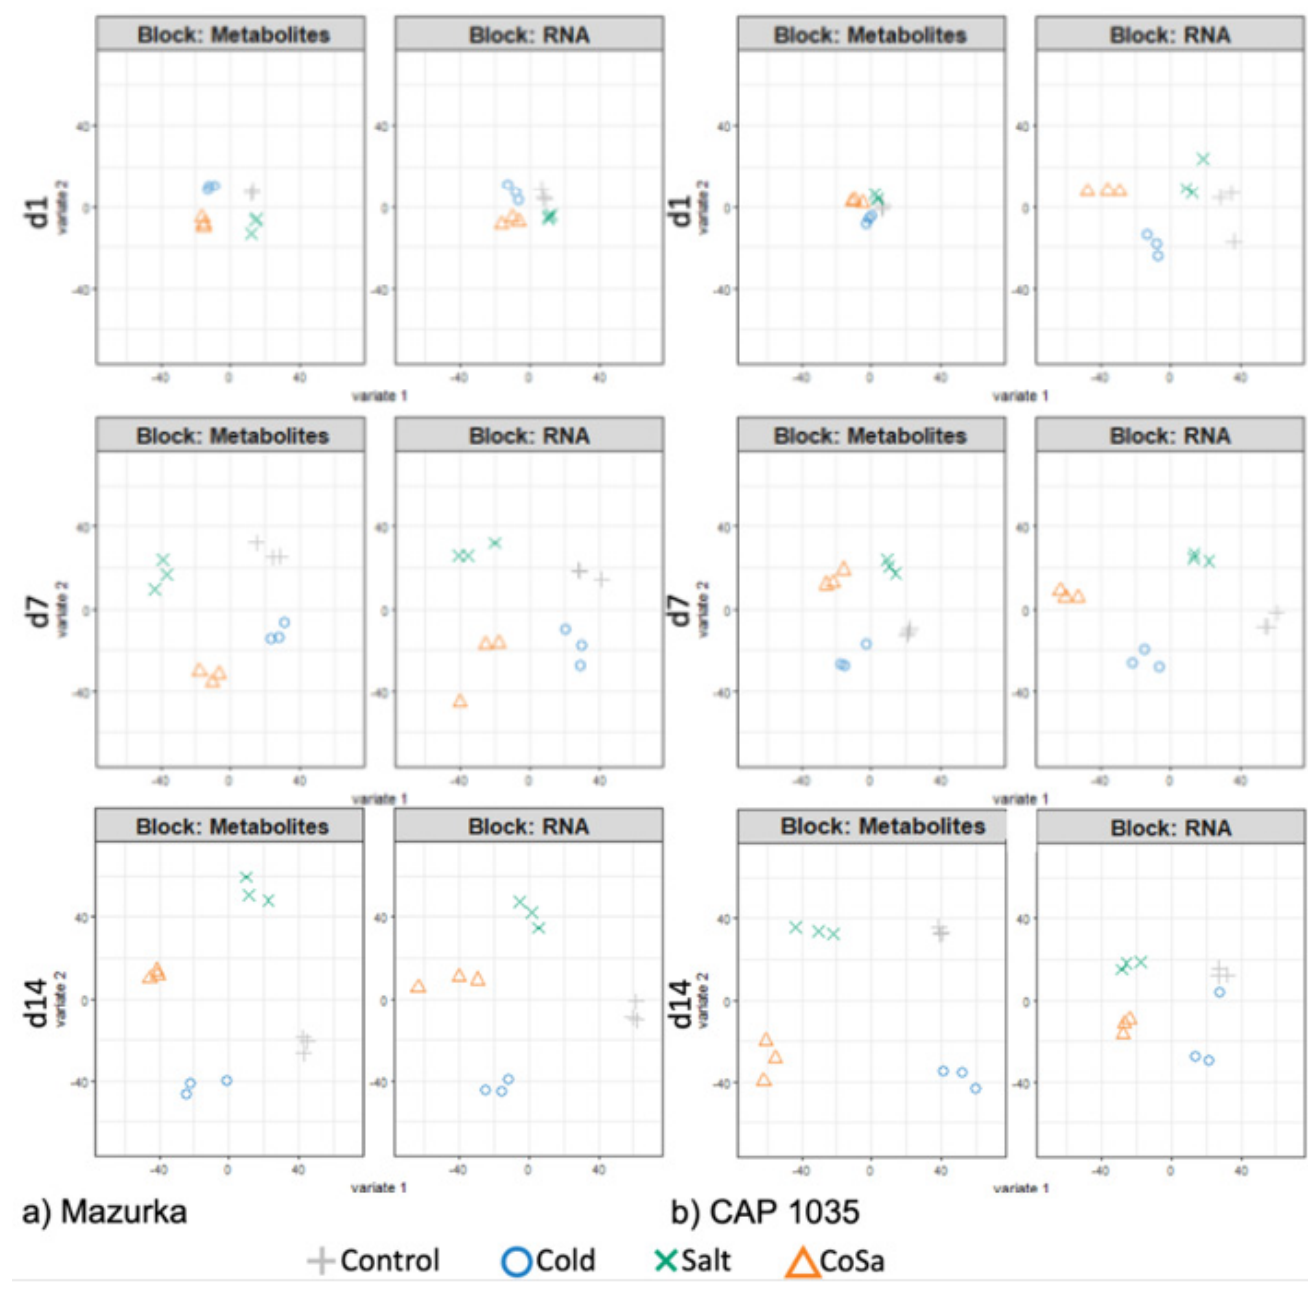
Figure 7. Scatter plot of multi-omics analysis (DIABLO) show the increasing response over time for Mazurka ( a ) and CAP1035 ( b ). Mass features and RNA transcripts were analyzed for each species separately at each harvest time point. Each point represents one sample. Different colors and symbols represent different treatments: control = grey cross, cold = blue circle, salt = green x, CoSa = orange